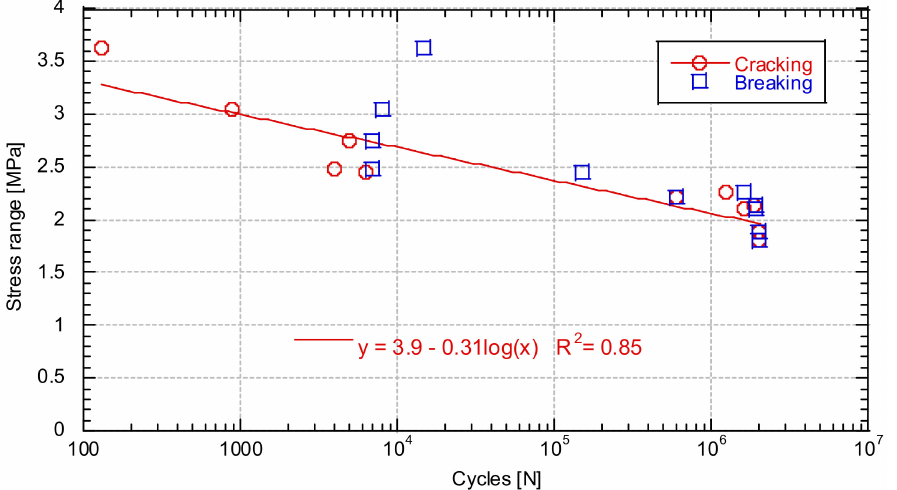
Figure 11. S-N curve.